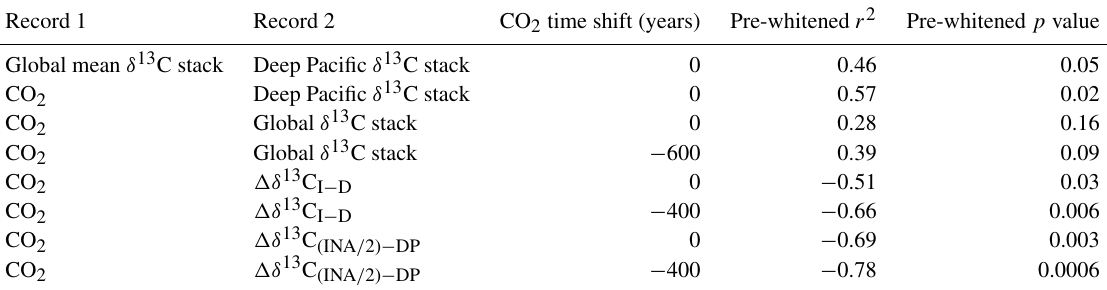
Figure 5. Four HadCM3 simulations of terrestrial carbon storage change (biosphere and soils) to the pre-industrial (blue, Davies-Barnard et al., 2017) compared to our volume-weighted global benthic δ 13 C stack (orange). Global mean δ 13 C change most closely resembles the simulation that releases carbon from under ice sheets to the atmosphere and does not store carbon on continental shelves (solid blue). The two y axes are scaled to illustrate the similarity in the pattern of change across the deglaciation but are not meant to imply that the magnitude of change is equivalent. Table 2. Correlation coefficients and p values between pre-whitened records. Pre-whitening reduces the impact of autocorrelation in the time series. Calculated p values account for the reduced degrees of freedom in pre-whitened and time-lagged correlations. Non-zero CO 2 time shifts indicate the lead/lag adjustment that maximizes the correlation between atmospheric CO 2 Köhler et al. (2017) and the δ 13 C stack or